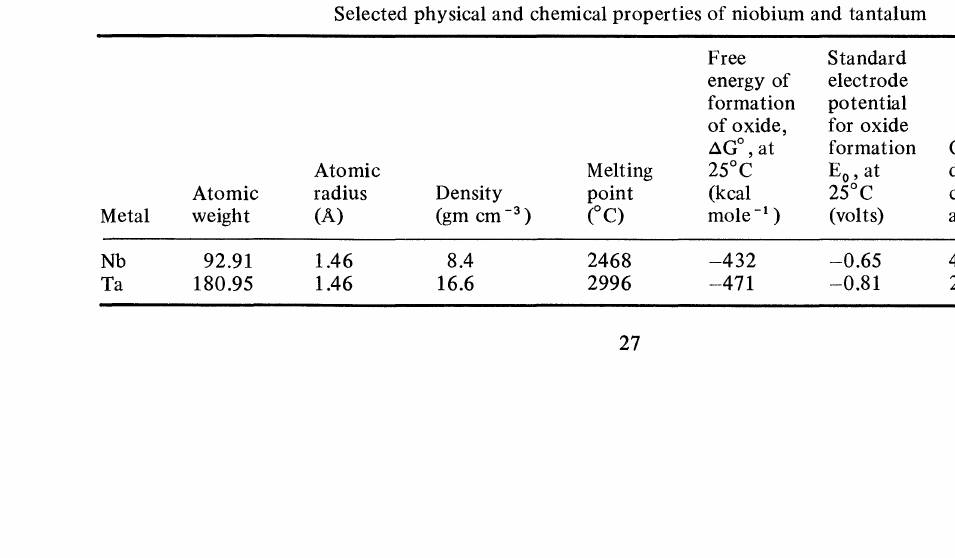
TABLE Selected physical and chemical properties of niobium and